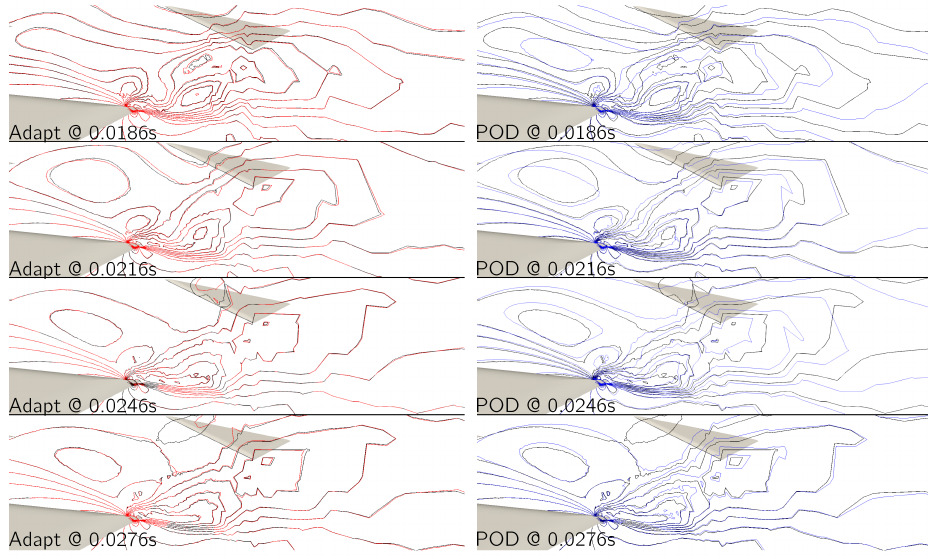
Figure 24. Detail of the volume solution in the region of vortices’ interaction, in terms of ρ for the formation flight test case. The black contours report the CFD reference solution; the coloured contour lines show the ROM reconstruction. The left column shows the adaptive reconstruction; the right column shows the pure POD reconstruction. Slice taken at 0.45 m from the plane of symmetry. Number of modes fixed, N m =